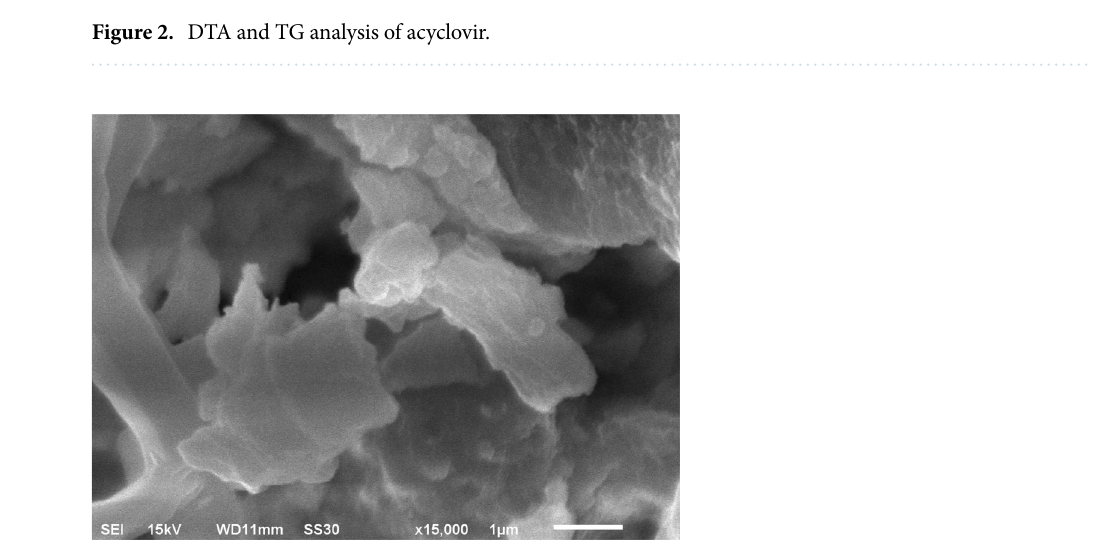
Figure 3. SEM image of a pseudoboehmite